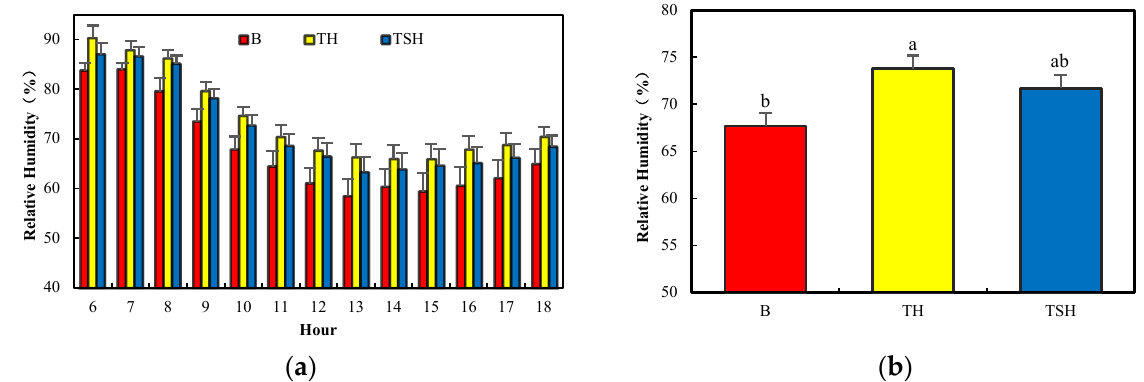
from 8:00 to 13:00 and reached its lowest value at 13:00. The lowest values of H B , H TH , and H TSH were 58.45 ± 3.50, 66.28 ± 2.78, and 63.24 ± 3.05%, respectively. The relative humidity basically remained stable from 13:00 to 15:00 and rose slowly from 15:00 to 18:00. There were some differences in relative humidity among the different vegetation type combinations. Figure 5b shows that H B < H TSH < H TH . H B was significantly lower than H TH ( p < 0.05). H B was lower than T TSH , but the difference in relative humidity was not significant ( p > 0.05). H TSH was close to H TH .